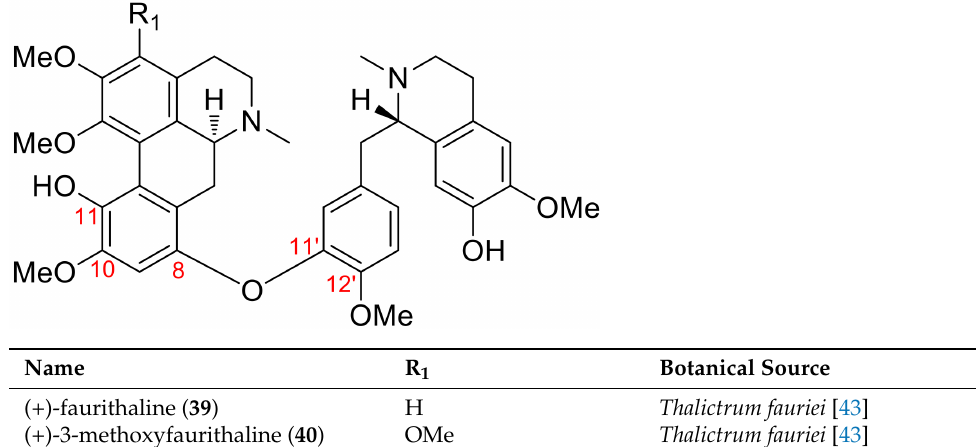
Table 5. Aporphine–benzylisoquinoline dimeric alkaloids belonging to a new type of reticuline– reticuline